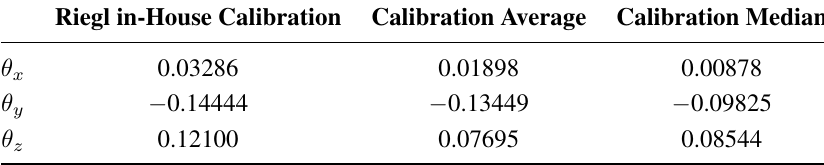
Table 2. Result of the outdoor boresight calibration experiment in